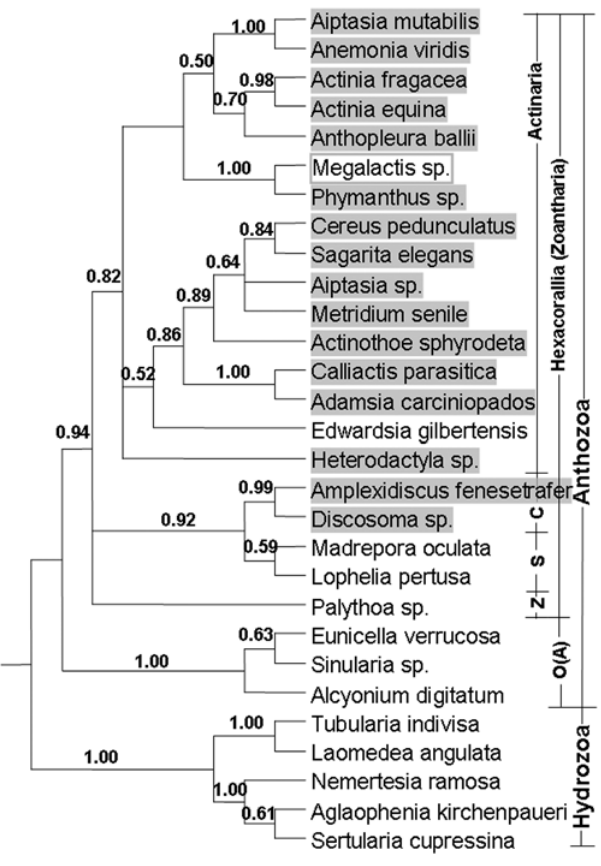
Figure 1. Cnidaria host genome phylogeny reconstructed using Bayesian methods from 18S, 5.8S and ITS data, and is a 50% majority rule consensus taken from the MCMC analyses after plateau (i.e. ‘burn- in’ trees discarded). The Bayesian posterior probabilities are given for each node. Taxa containing a HEG are highlighted; the non-functional HEG is boxed. Taxonomic classification is also distinguished; O(A) = Octocorallia (Alcyonaria); C = Corrimorpharia; S = Scleratinia; Z =